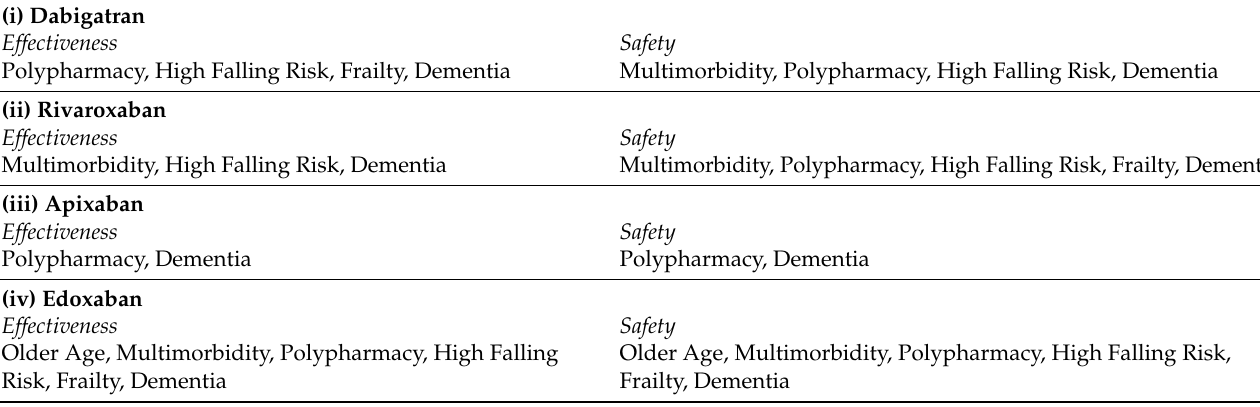
Table 2. Geriatric Conditions with Limited Evidence on